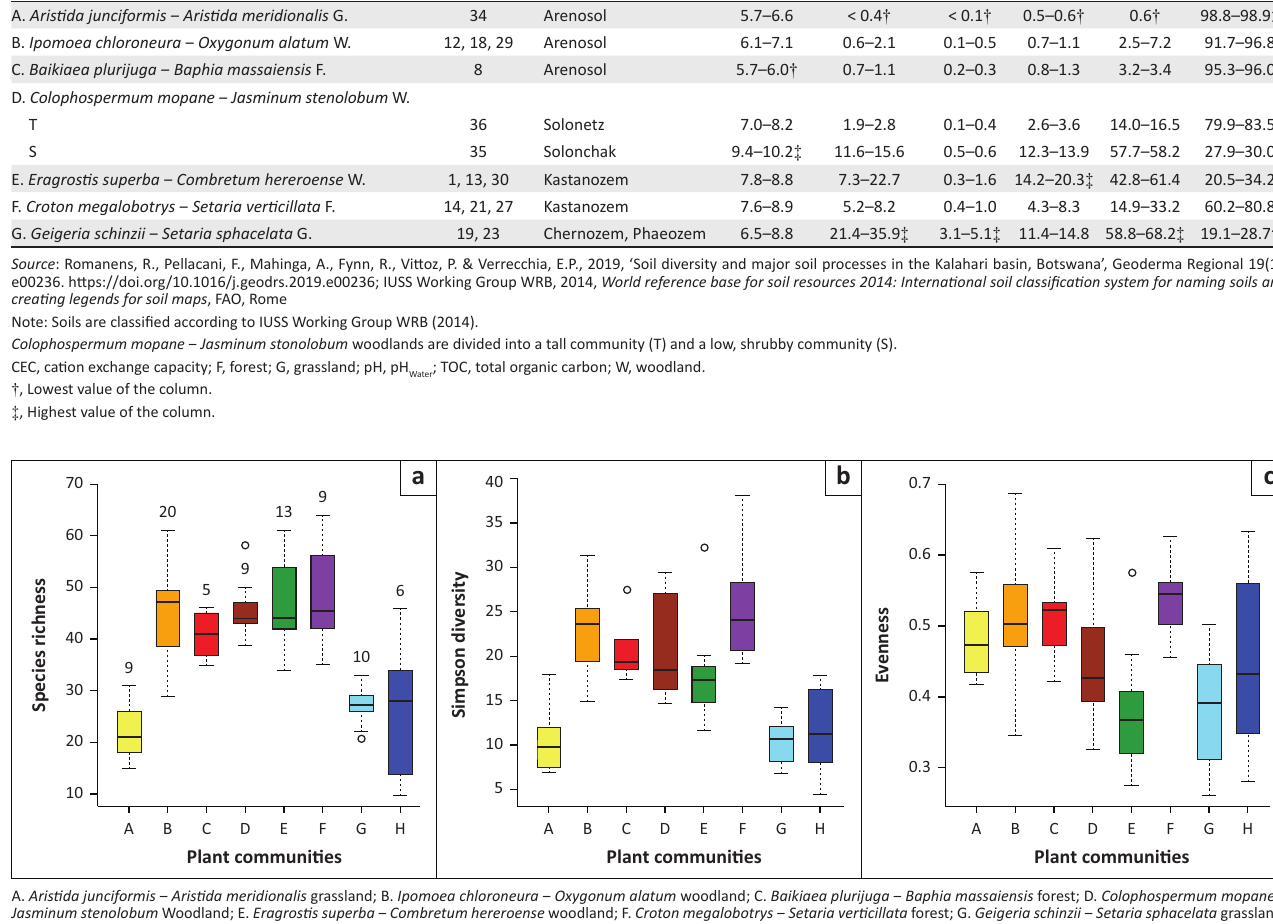
FIGURE 3: Species richness (a), Simpson diversity index (b) and species evenness (c) for the eight plant communities in the Chobe Enclave. The black line is the median, boxes are limited by 1st and 3rd quartiles and the length of the whiskers corresponds to 1.5 SD. The number of sample plots included in the group is indicated above the whiskers in